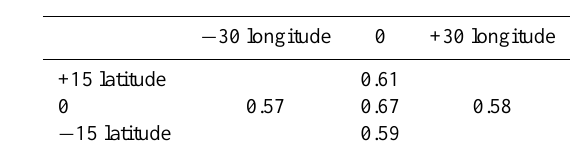
Table 5. TES and CarbonTracker correlations at and offset from GLOBALVIEW locations.